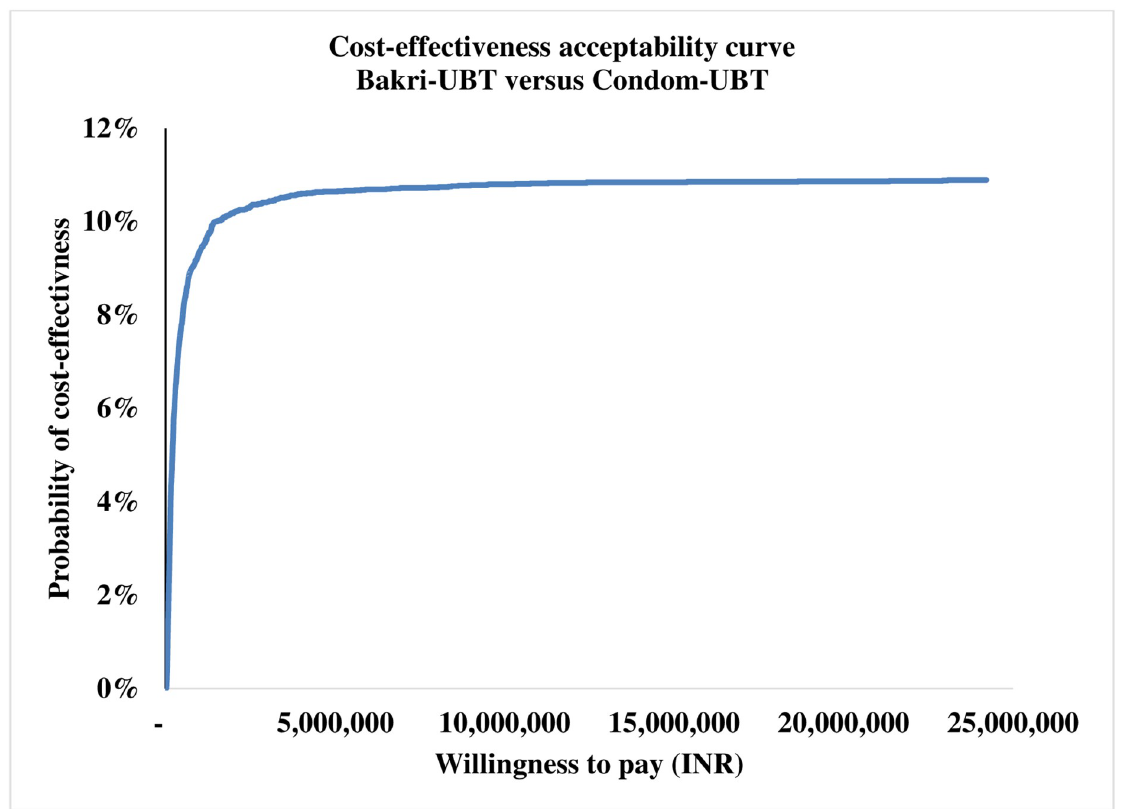
Fig 7. Cost-effectiveness acceptability curve for ESM-UBT versus condom-UBT comparison.